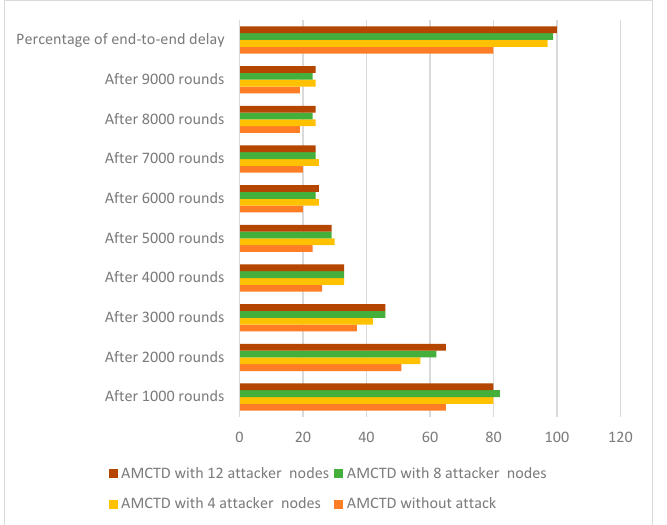
Figure 13. End-to-End Delay of AMCTD without Attack, AMCTD with 4, 8 and 12 Attacker Nodes.